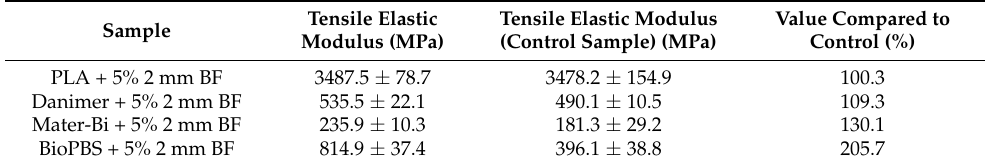
Table 12. Tensile elastic modulus comparison of the 1st generation with the control sample (without fiber).